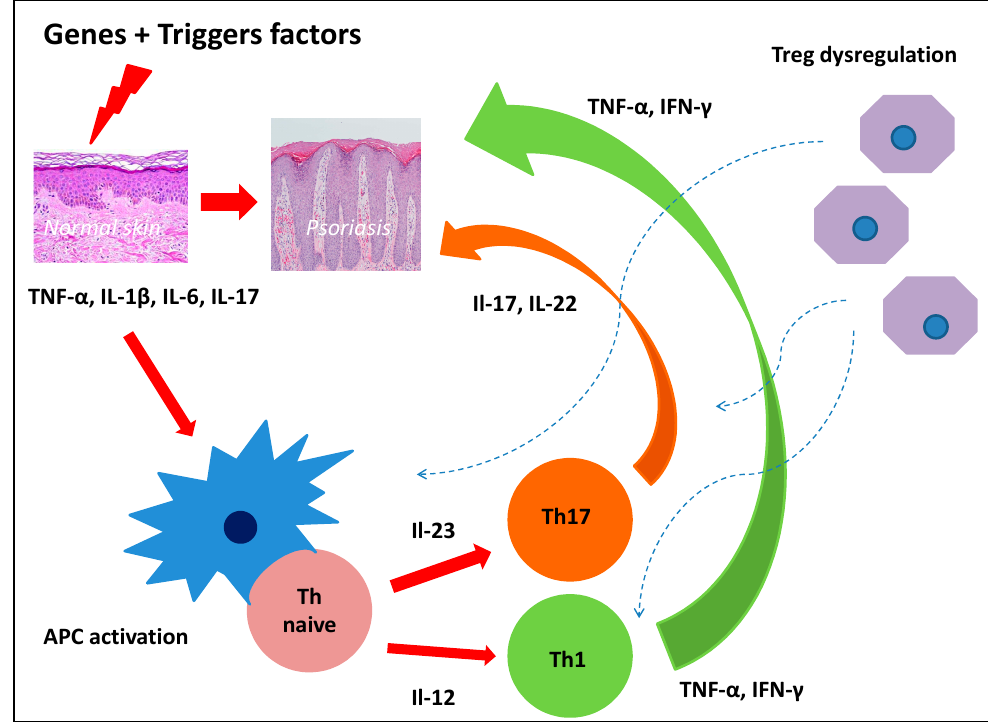
Figure 1. Dysregulation of the inflammatory response in psoriasis.